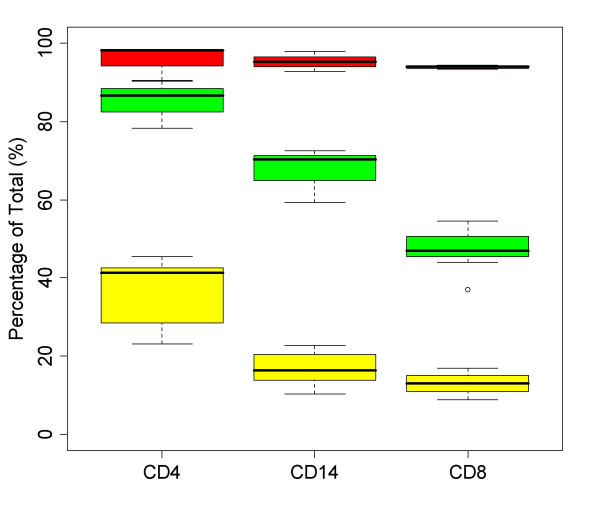
Positive selection is associated with increased cell purity. Proportion of cell types (CD4, CD8 and CD14) in PBMC as assessed by flow cytometry prior to separation (yellow boxes). Purity of these cells assessed by flow cytometry following positive (red boxes) or negative (green boxes) selection.